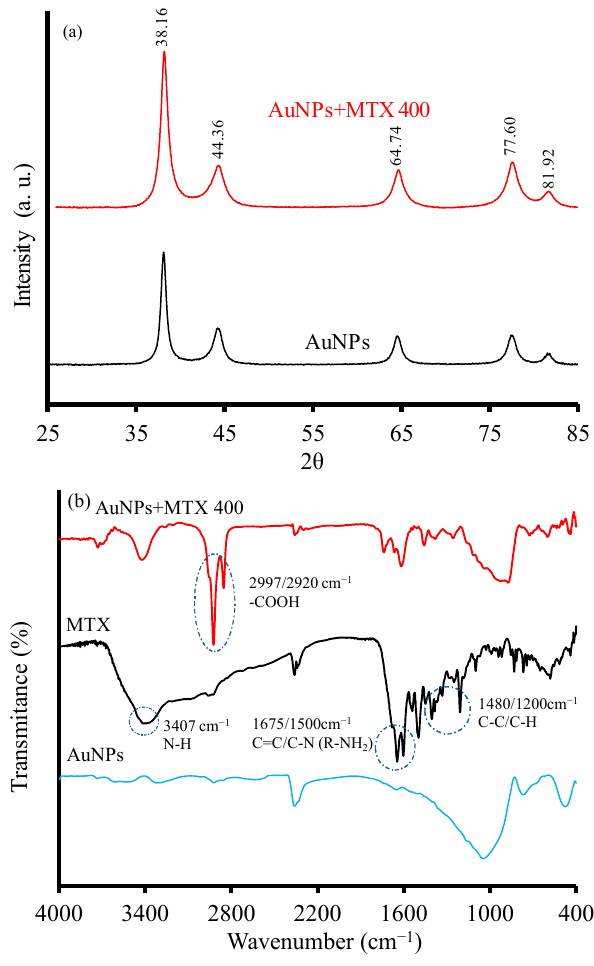
ff ractograms of AuNPs and AuNP–MTX400. ( b ) FTIR spectra of free MTX, Figure 2. ( a ) XRD diffractograms of AuNPs and AuNP–MTX400. ( b ) FTIR spectra of free MTX, gold Figure 2. ( a ) XRD di gold nanoparticles (AuNPs) and MTX conjugates